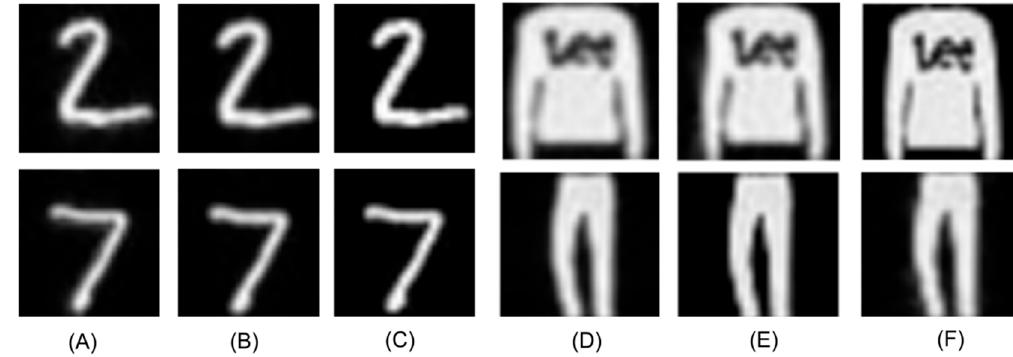
Figure 8. ( A ) Lower resolution MNIST image; ( B ) FPM reconstructed MNIST image; ( C ) original MNIST image; ( D ) lower resolution Fashion MNIST image; ( E ) FPM reconstructed fashion MNIST image; ( F ) original Fashion MNIST image.